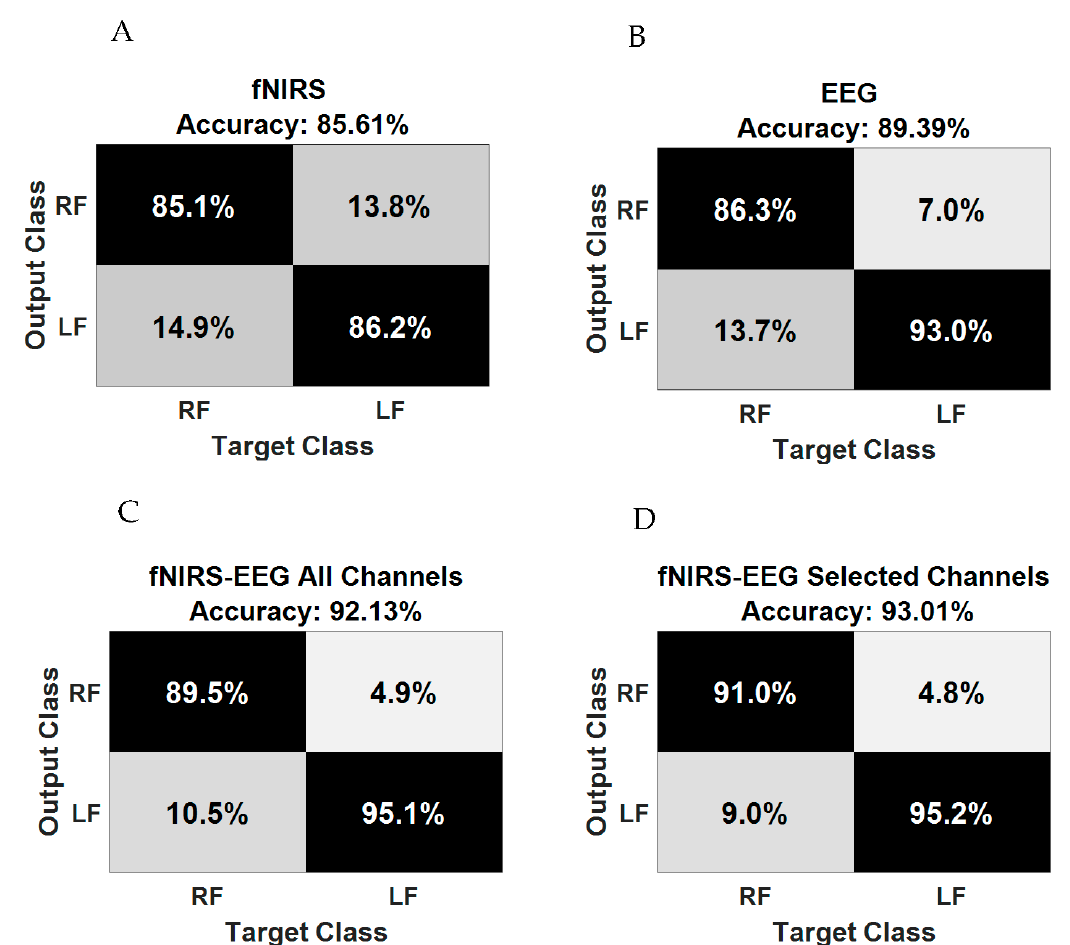
Figure 12. Confusion matrix of ( A ) fNIRS alone, ( B ) EEG alone, ( C ) fNIRS–EEG based on all channels, and ( D ) fNIRS–EEG based on selected channels.